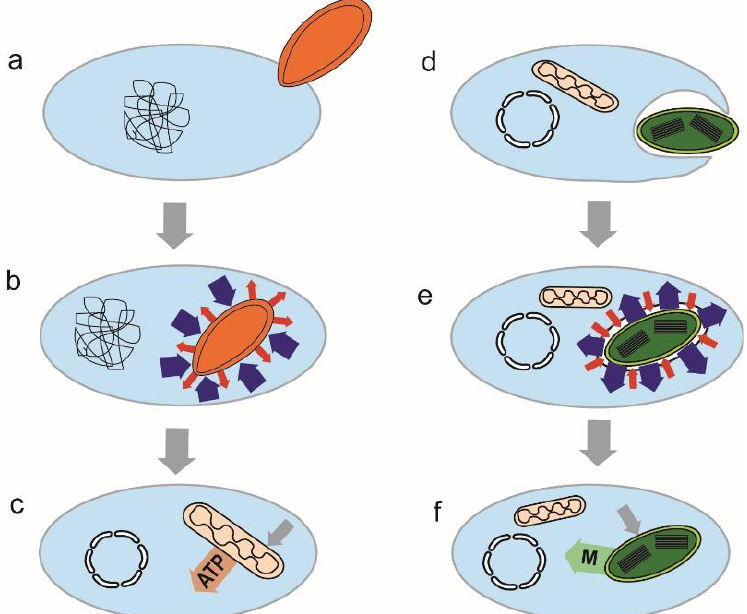
Figure 4. Two possible types of endosymbiotic events. In the first type, the endosymbiont ( a – c ) is a parasitic bacterium, which actively invades the host cell ( a ). The defense of the host (( b ), blue arrows) against parasitic endosymbiont (red arrows) transformed the parasitic relationship to mutualism ( c ). Endosymbiotic gene transfer, together with gradual losses of redundant pathways, led to the mutual dependence of the host and symbiont. The second type of event ( d – f ) is based on hunting. The cyanobacterial prey is engulfed by phagocytosis ( d ). The bacterium resists (blue arrows) digestion (red arrows) ( e ). The photosynthetic endosymbiont provides primary metabolites (M) to the host cell in a mutualistic relationship. This type of organellogenesis resembles domestication. In both cases, the endosymbiont provides (non-essential) benefit to the host.